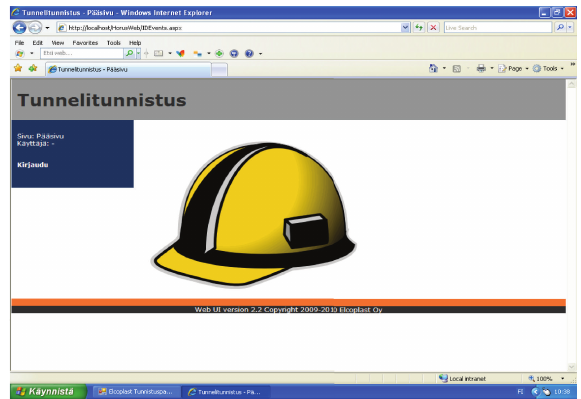
Figure 14: The start page of the tunnel identification